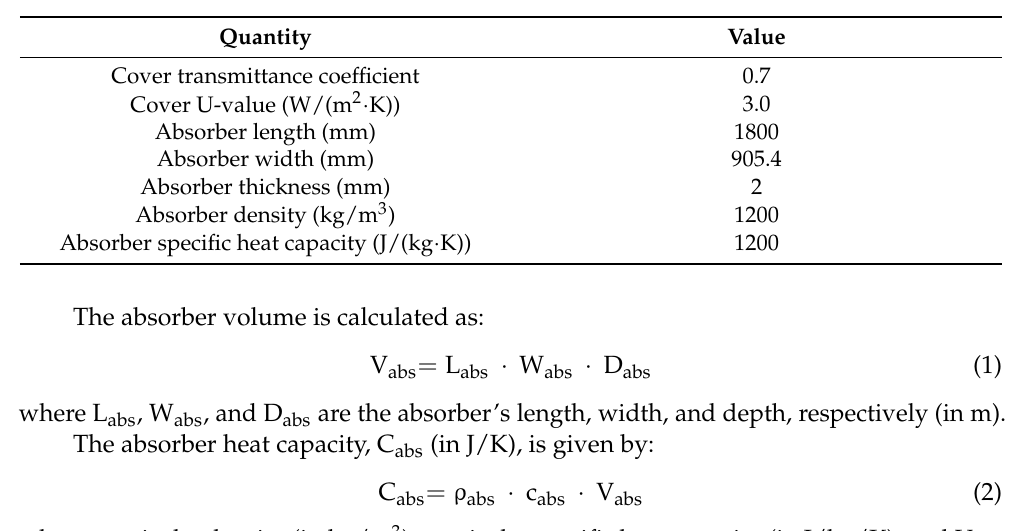
Table 2. Assumptions about the technical characteristics of the SAH.